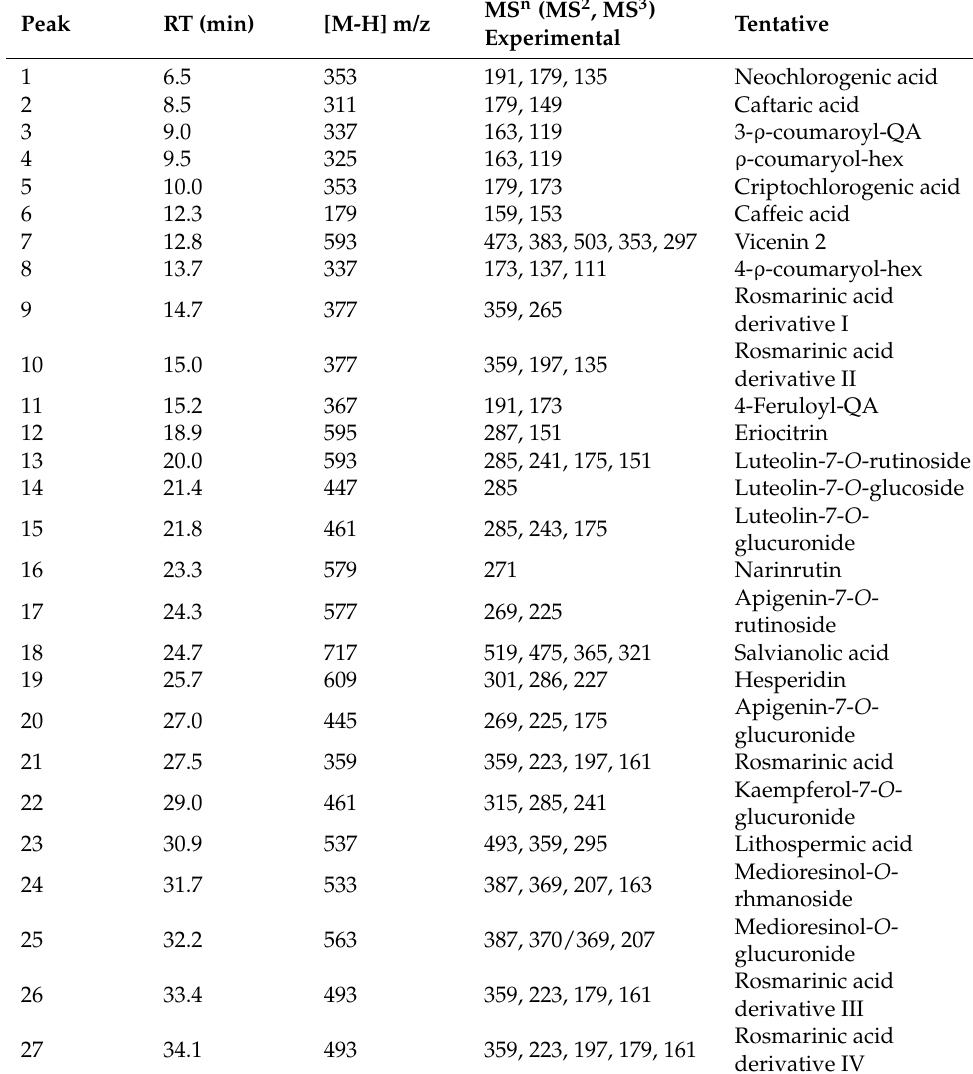
Table 2. Main compounds in M. spicata tentatively identified by HPLC-DAD-ESI/MS n .